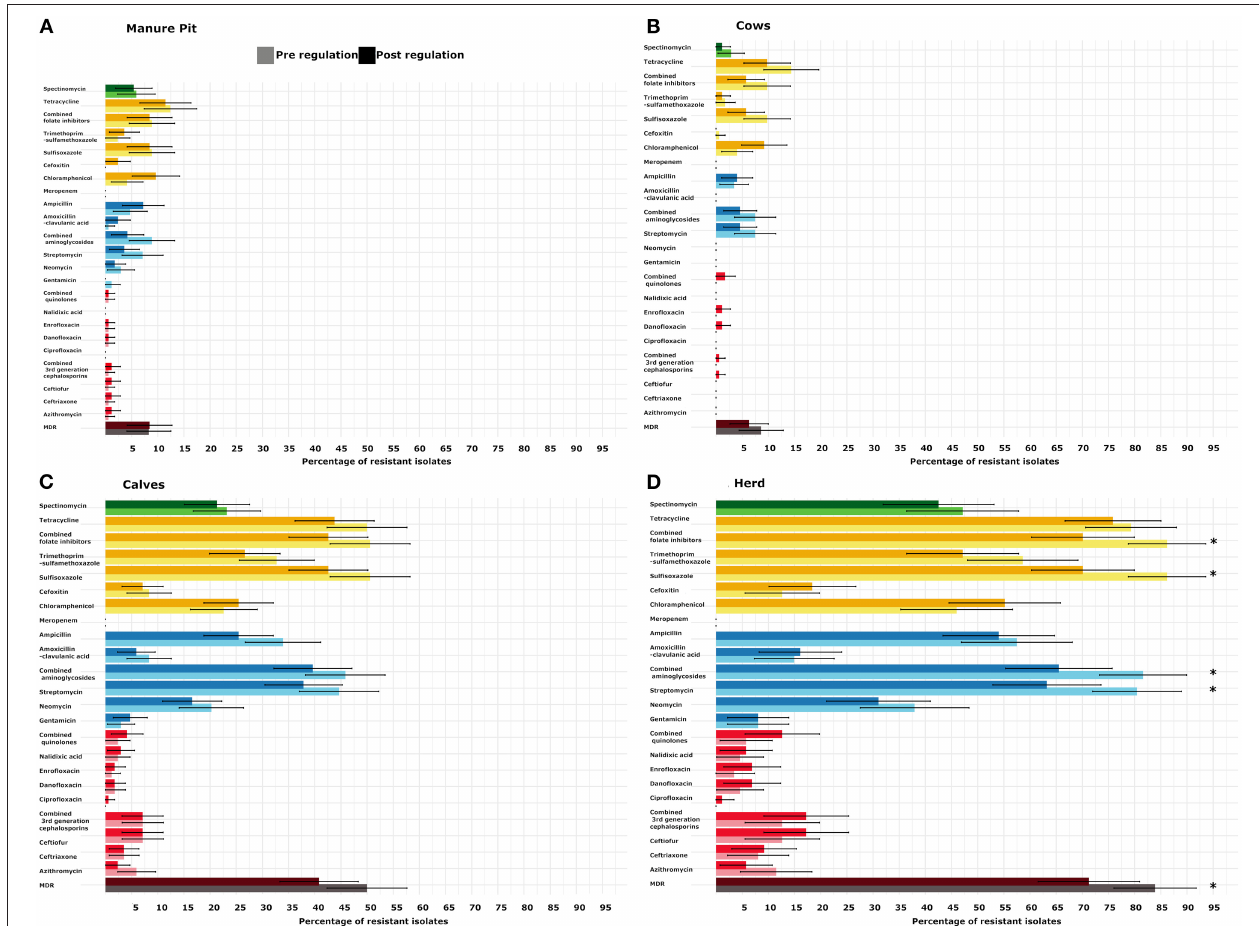
FIGURE 3 | Comparison of the proportion of isolates with at least one resistant (intermediate and resistant combined) Escherichia coli per period [pre- (light) and post-regulation (dark)] and sample type [manure pit (A) , cows (B) , calves (C) ] or for the whole herd (D) from 87 dairy farms from Québec, Canada. On each farm, between 4 and 6 E. coli were tested for each antimicrobial. In dark and light burgundy, MDR: multidrug resistant (resistant to 3 classes of antimicrobial or more). In dark and light red, critical high priority antimicrobials for human medicine. In dark and light blue, critical priority antimicrobials for human medicine. In dark and light yellow, high priority antimicrobials for human medicine. In dark and light green: antimicrobials important for human medicine, SPE: spectinomycin. The importance of antimicrobial for human medicine was defined according to World Health